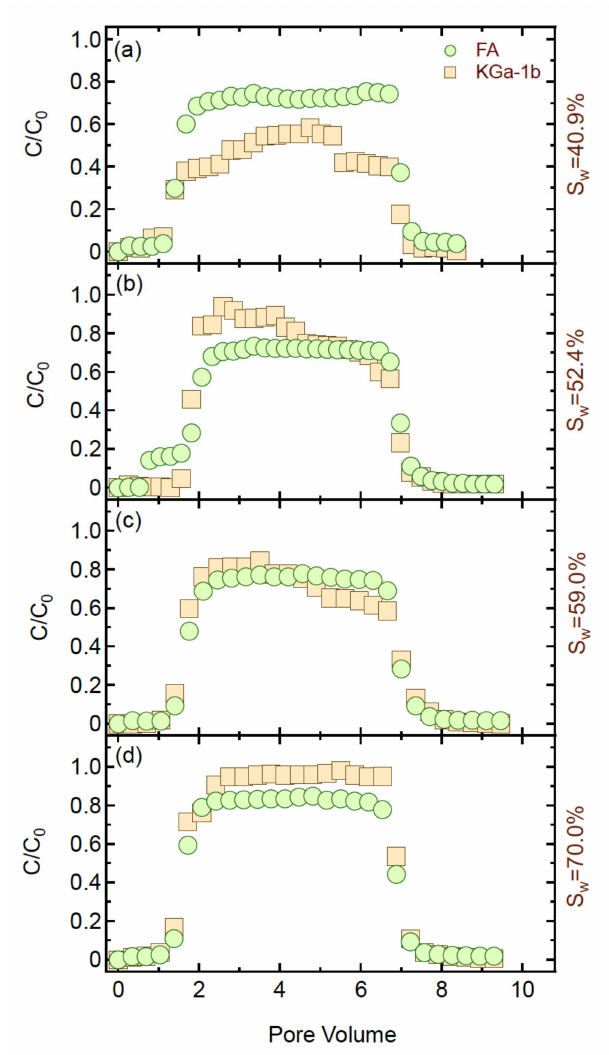
Figure 3. Breakthrough data from the co-transport experiments with FA and kaolinite particles in unsaturated columns packed with sand under various flow rates: ( a ) 1, ( b ) 1.5, ( c ) 2, and ( d ) 3 mL /